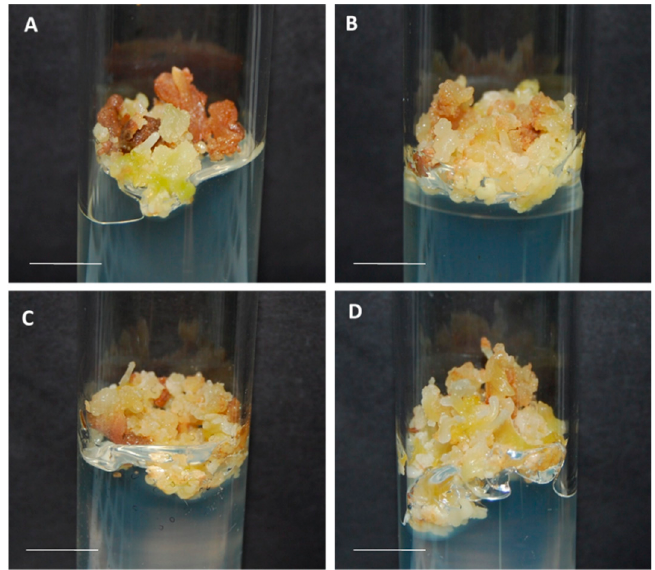
Figure 1. Appearance of olive embryogenic cultures ( A , C ) control and ( B , D ) derived from cryopreserved somatic embryos of the lines T1 ( A , B ) and P5 ( C , D ), six weeks after the last subculture on proliferation medium. Bar = 1 cm.